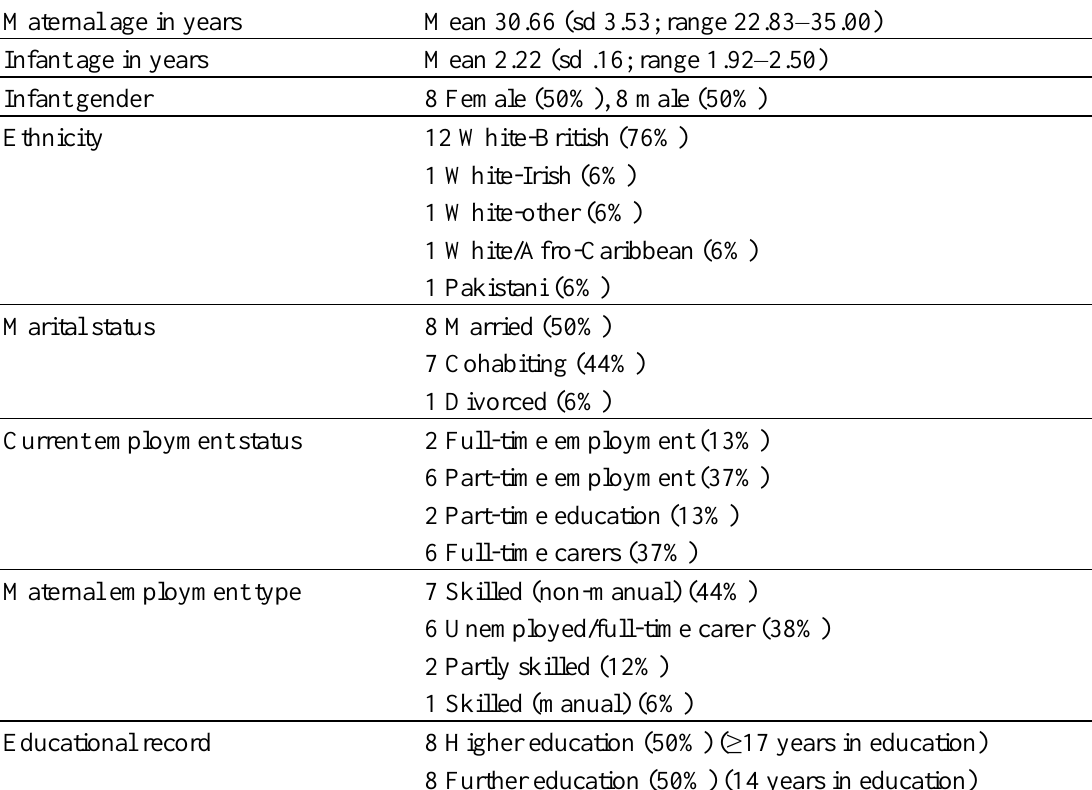
Table 1. Demographic details of the